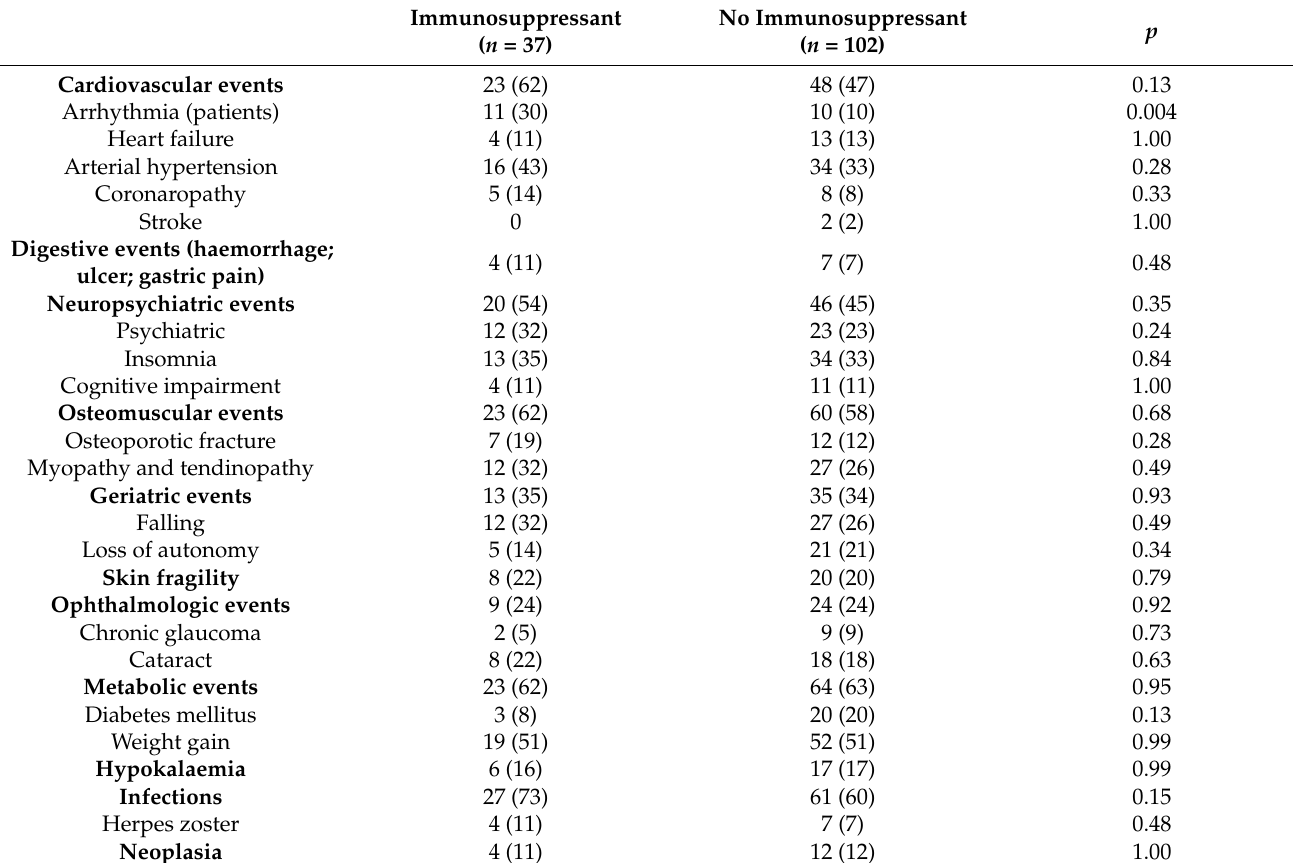
Table 5. Adverse events in GCA patients according to whether they received an immunosuppressant.